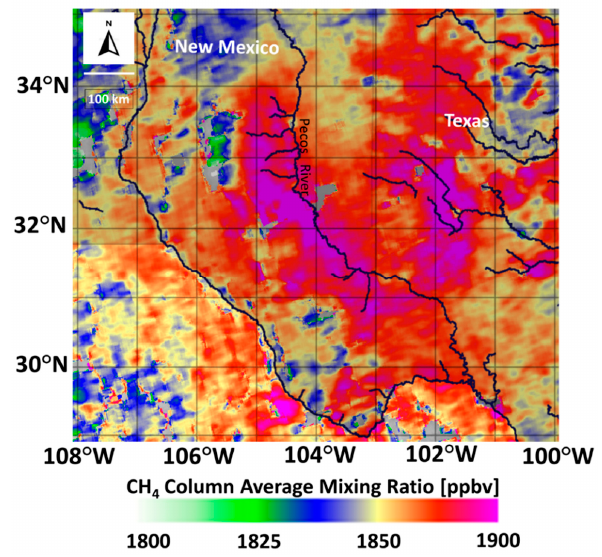
Figure 3. Average TROPOMI CH 4 column average mixing ratio (ppbv) over the Permian Basin region (denoted in Figure 1) for the 24-month period 1 December 2018–1 December 2020. Because CH 4 has a long lifetime (several years) in the atmosphere and is comprised of both local and background sources, variable CH 4 columns are noted throughout the Permian Basin. In addition, variability (in both space and time) in background CH 4 meas- urements and trends are noted regionally, so it is not possible without more detailed anal- ysis of background CH 4 measurements combined with local source emission data to quan- tify the relative magnitude of local versus non-local (background) and anthropogenic ver- sus non-anthropogenic CH 4 from satellite imagery. Finally, because the Playa desert re- gions to the west of the Permian Basin have high albedo, the CH 4 retrievals shown in Fig- ure 3 in that region are likely biased high based on comparison with a recent study that included albedo corrections [50]. Over the main portion of the Permian Basin, the albedo is in the moderate range (0.15–0.25) [68], so large impacts on the retrievals from either excessively high albedo such as observed over reflective playas or very low albedo such as observed over the northeastern great plains as discussed in [25] are not expected. The regions with the highest average CH 4 column average mixing ratio (Figure 3) are located in a broad swath encompassing the most dense ONG production regions, but also extending west and northwestward between 50 and 125 km from the western edge of the primary ONG production regions (Figure 3). This region is bounded to the east by the Pecos River Valley and to the west by the eastern slopes of the West Texas and New Mex- ico mountains (Figure 1). As discussed in Section 3.3, the northwestward transport of CH 4 by upvalley and upslope flows is hypothesized to contribute to the observed western en- hancements in TROPOMI CH 4 columns (Figure 1).